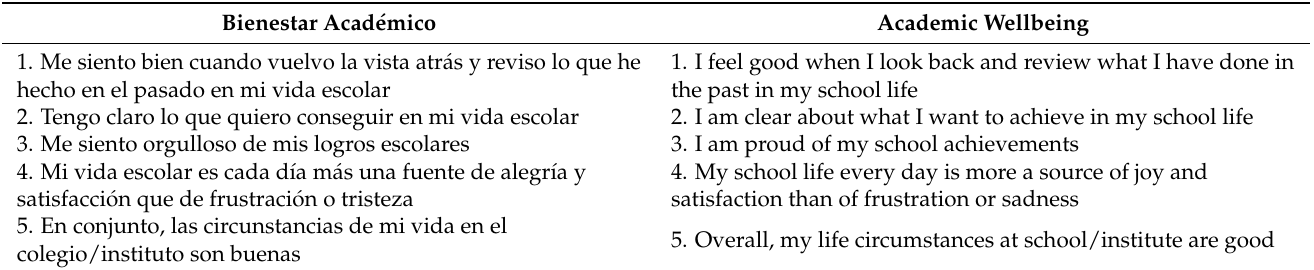
Table A2. Spanish and English versions of the Subjective Academic Wellbeing Scale. Bienestar Acad é